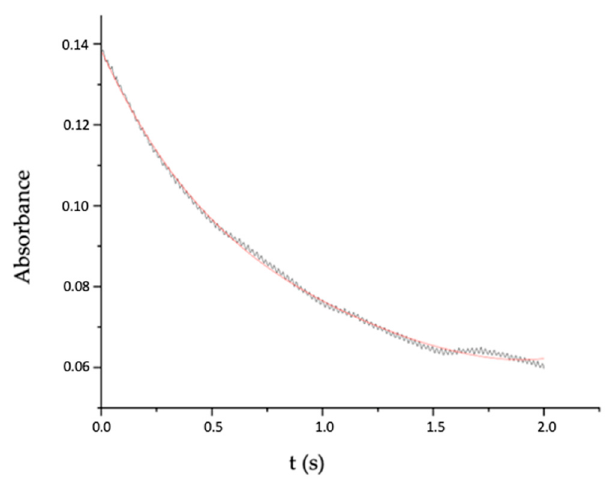
Figure 1. Absorbance vs. time plot, [p-HBZH] = 8.00 × 10 − 5 M, [HOONO] = 2.00 × 10 − 3 M, T = 25 °C, pH = 2, I = 0.1 M.Black line: experimental data. Red line: curve fit to the Equation (1).